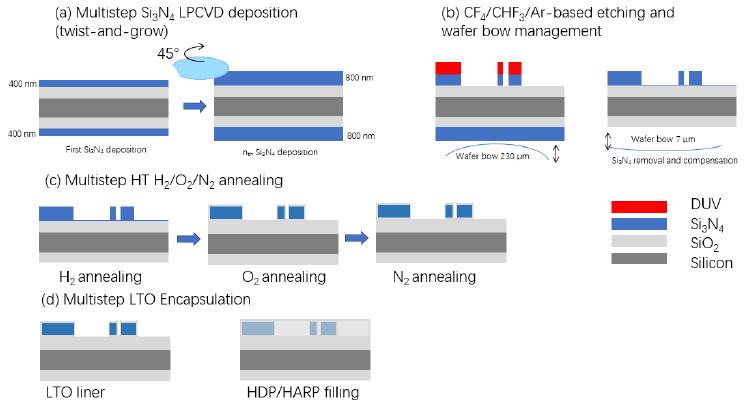
Figure 9. Schematics of the twist-and-grow and multistep chemical-physical annealing process for ultralow-loss tightly confining Si 3 N 4 waveguides. ( a ) 3-μm thick wet oxidation of a 200-mm Si wafer is followed by a twist-and-grow deposition of Si 3 N 4 films until matching the desired film thickness (800 nm). ( b ) Fluorocarbon-based dry etching and wafer bow compensation. ( c ) Multistep H 2 /O 2 /N 2 in-situ annealing of patterned core Si 3 N 4 waveguides. ( d ) Multistep encapsulation via a low-temperature silicon dioxide liner before high-density plasma silica layers